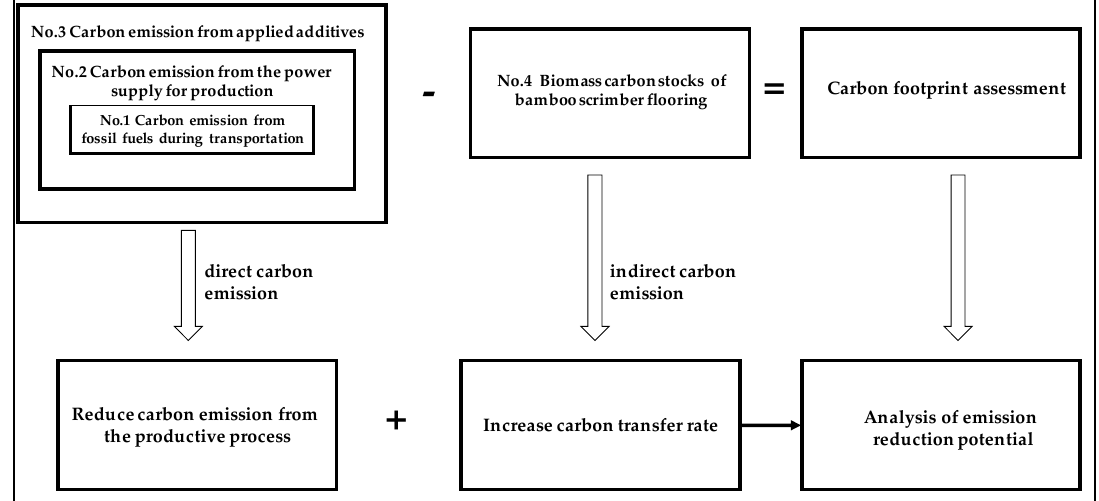
Figure 3. An analysis framework for the decomposed carbon footprint of bamboo scrimber flooring.